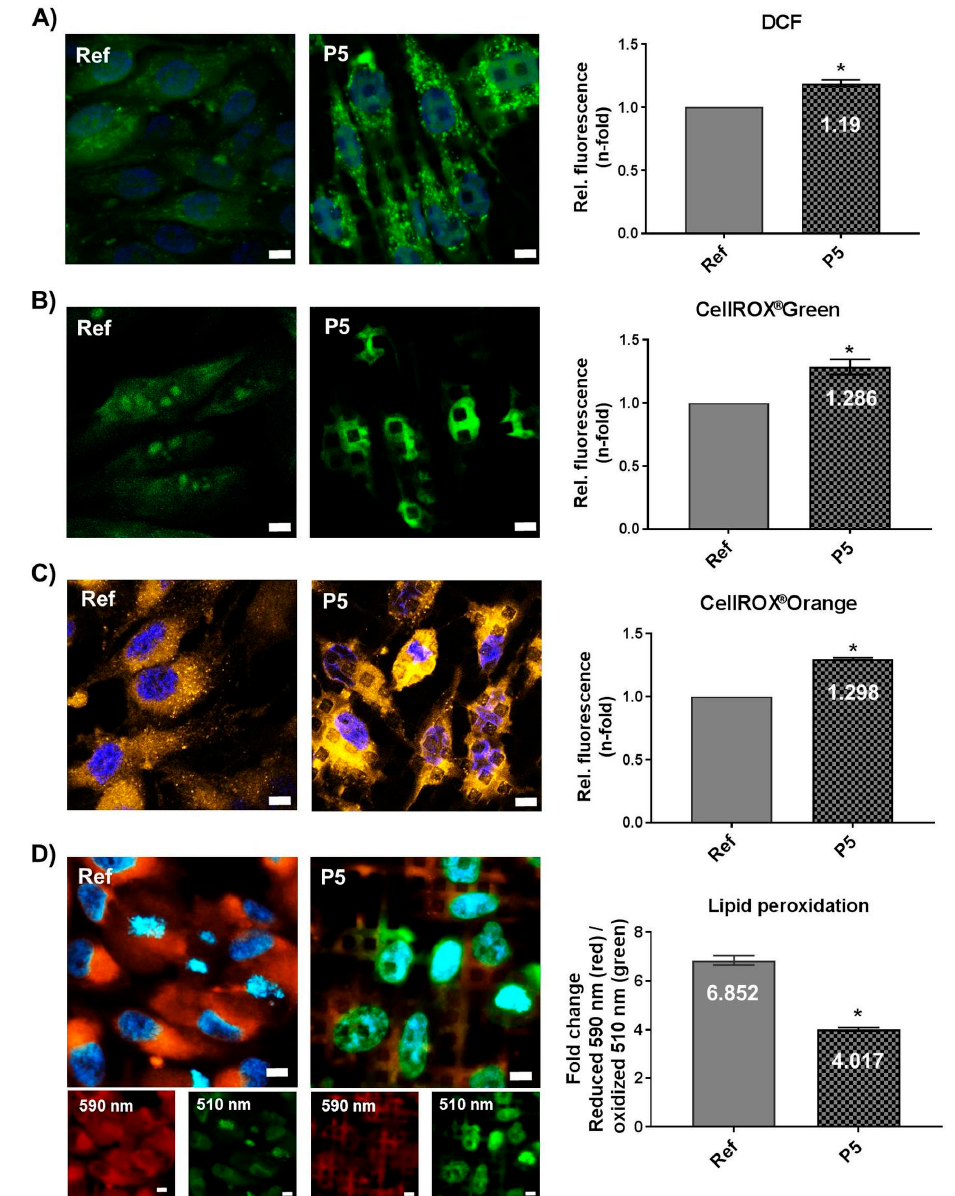
Figure 6. Reactive oxygen species (ROS) generation and lipid peroxidation in MG-63s on micro-pillars (P5) after 24 h; (Left) laser scanning microscopy (LSM) and (Right) Tecan reader. ( A ) ROS determination of fluorescent DCF (DCFDA cellular ROS detection assay). ( B ) Nuclear and mitochondrial determination of ROS with CellROX ® Green reagent. ( C ) Cytosolic determination of ROS with CellROX ® Orange reagent. ( D ) The oxidative degradation of cellular lipids was analyzed by Image-iT ® lipid peroxidation kit. Representative LSM images—upon oxidation fluorescence shift from 590 (red) to 510 (green) and level of lipid peroxidation as measured by the ratio of red (590 nm): green (510 nm) fluorescence. Note that micro-pillars induced significant higher ROS in the cytosol as well as in the nucleus and mitochondria. As consequence the oxidative degradation of cellular lipids occurred. (TECAN infinite M200; mean ± s.e.m., 4 independent experiments; B–C: Ref values are normalized to 1; paired t -test; * p < 0.05.). (LSM 780, Carl Zeiss; blue: nucleus, Hoechst 33324; magnification 40×, scale bar: 10 µm).